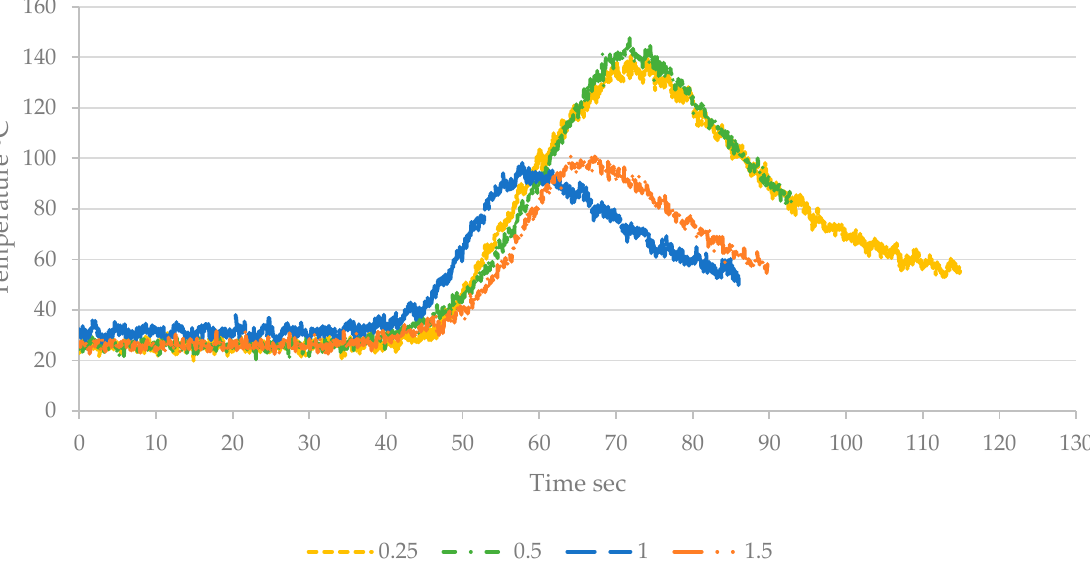
Figure 9. Effect of changing the feed rate during the weld stroke on temperature from R DWP = 0.25 to 1.5.